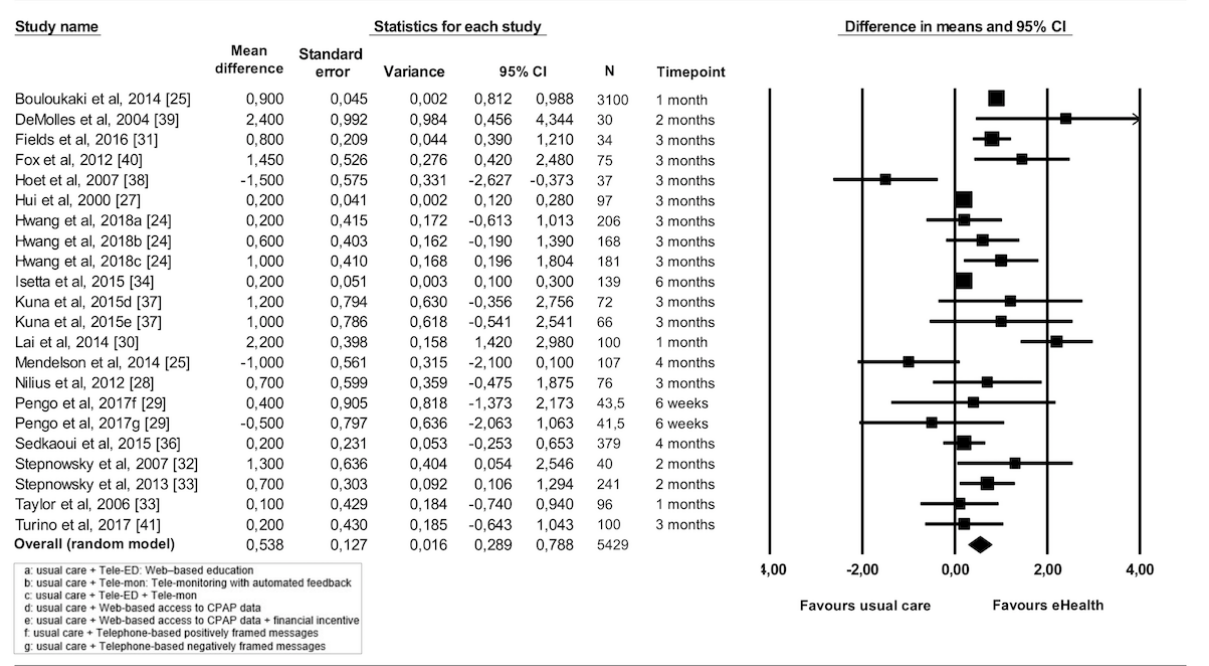
Figure 4. Forest plot of intervention effects on adherence as defined as mean nightly continuous positive airway pressure (CPAP) use in